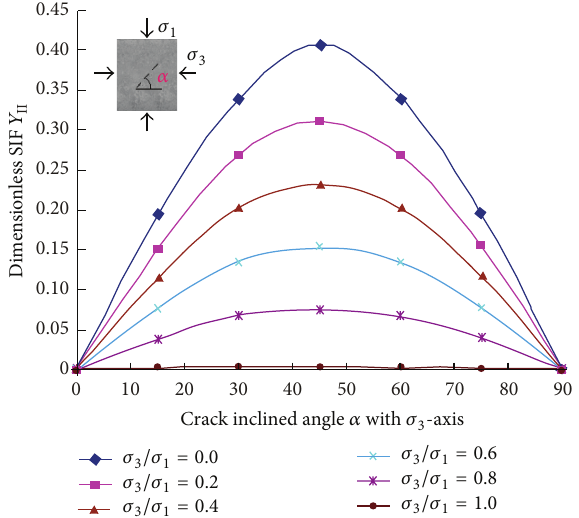
Figure 9: Curves of 𝑌 ΙΙ of crack tip A under different confining stresses and